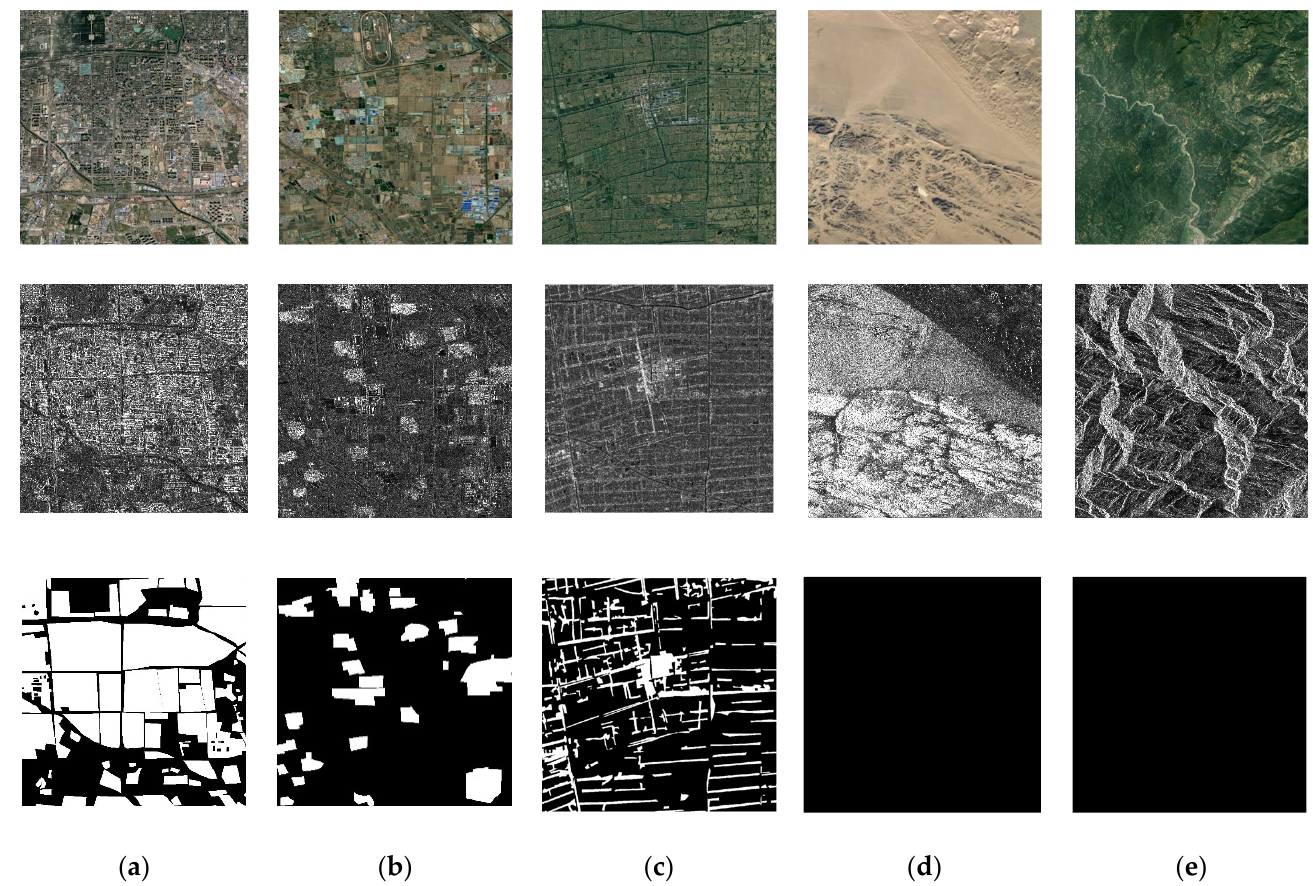
Figure 6. Google Earth images, SAR images, and labels of the dataset: ( a ) Urban areas, ( b ) rural areas, ( c ) strip-shaped buildings, and ( d,e ) negative samples. White and black on the labels represent built-up and non-built-up areas, respectively.